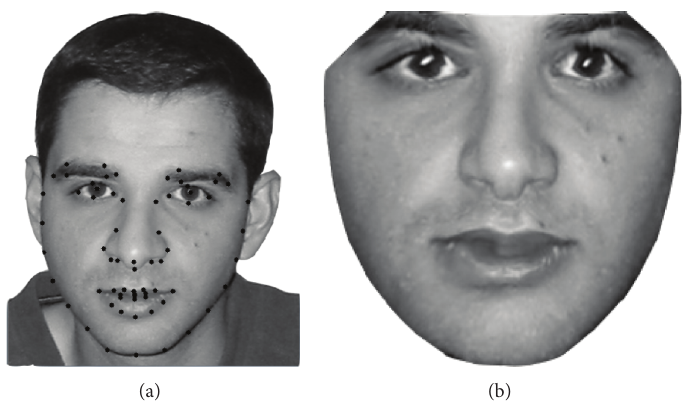
Figure 1: (a) Shape and (b) the shape-free